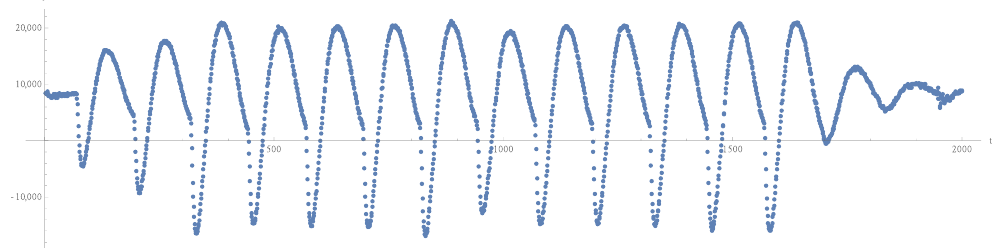
Figure 3. Rijndael/AES encryption FPGA power